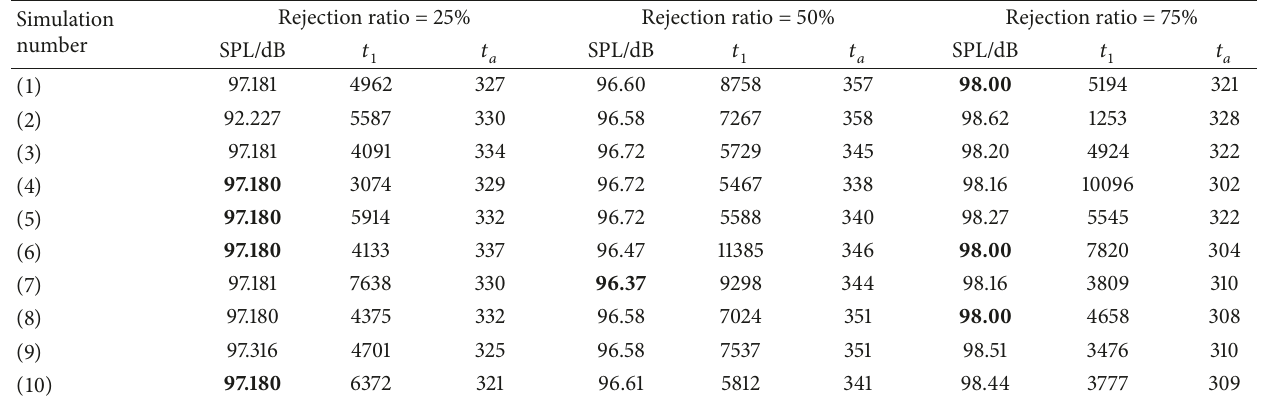
Table 5: Execution time in seconds using GA for second